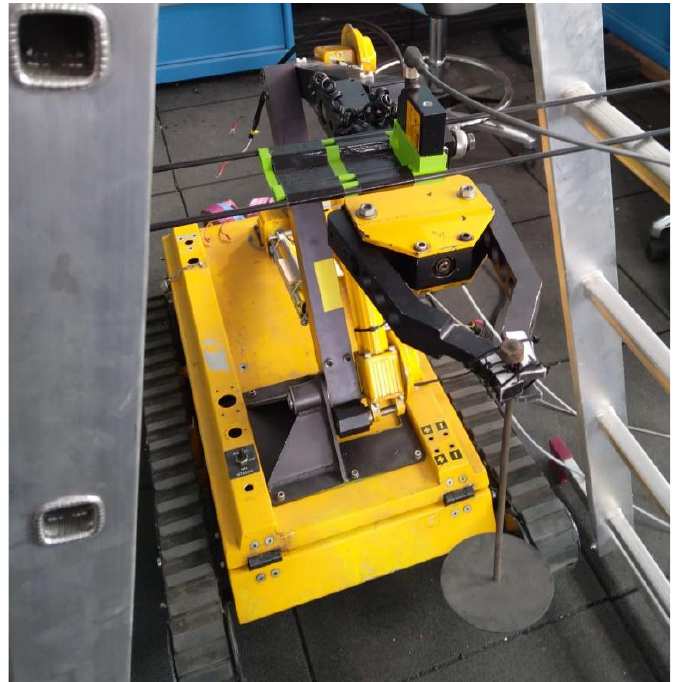
Figure 2. The analyzed EOD robot and the hook for positioning the working weights.